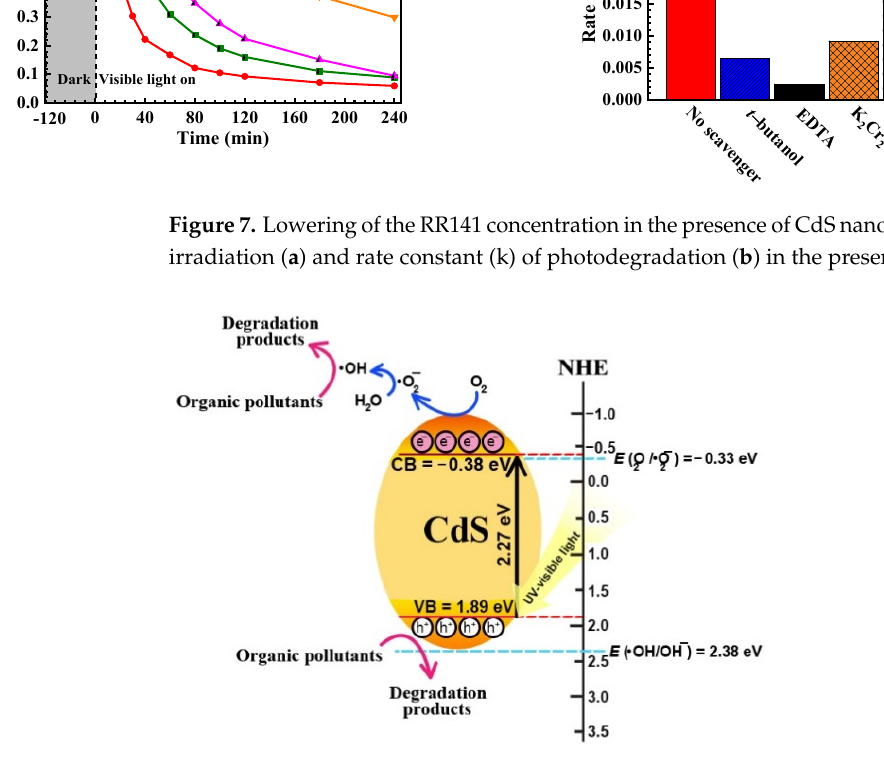
Figure 8. Photocatalytic mechanism schemes of CdS nanoparticles toward the degradation of organic pollutants under UV-visible light irradiation.